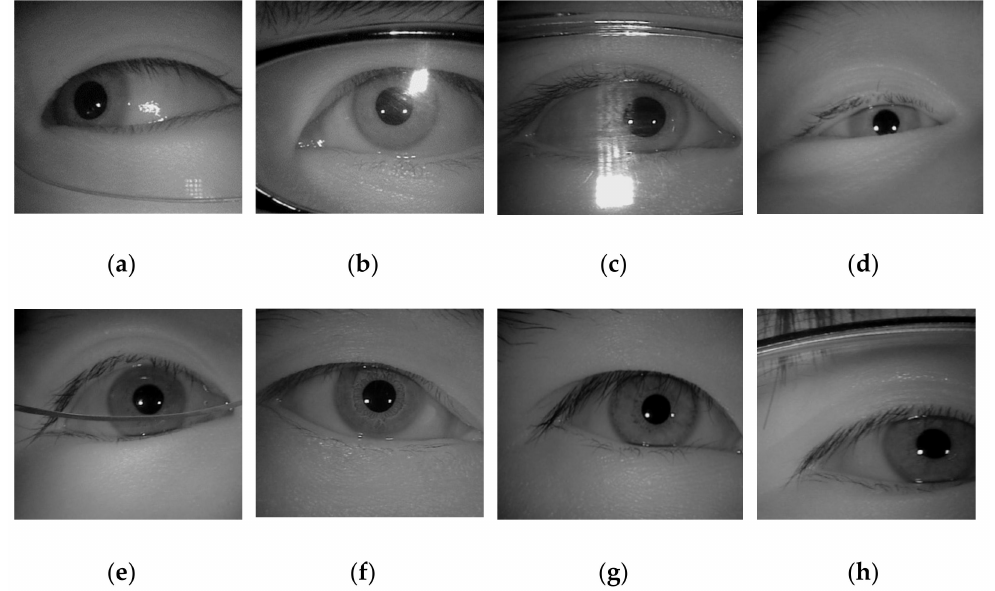
Figure 1. Example of images captured under non-cooperative environments. ( a ) Off-angle iris; ( b – c ) iris with specular reflection; ( d ) iris occluded by eyelids; ( e ) iris obstruction due to glasses; ( f ) rotated iris image; ( g ) iris obstruction due to eyelash; ( h ) partially captured